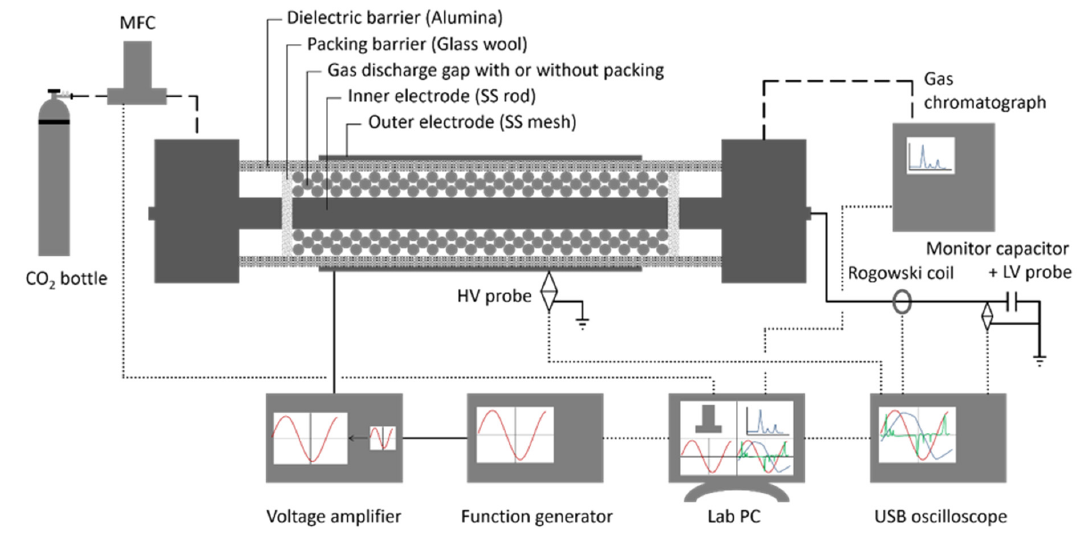
Figure 3. Packed bed DBD plasma reactor used in this work, along with analytical equipment (reprinted from [5] with permission from Elsevier).